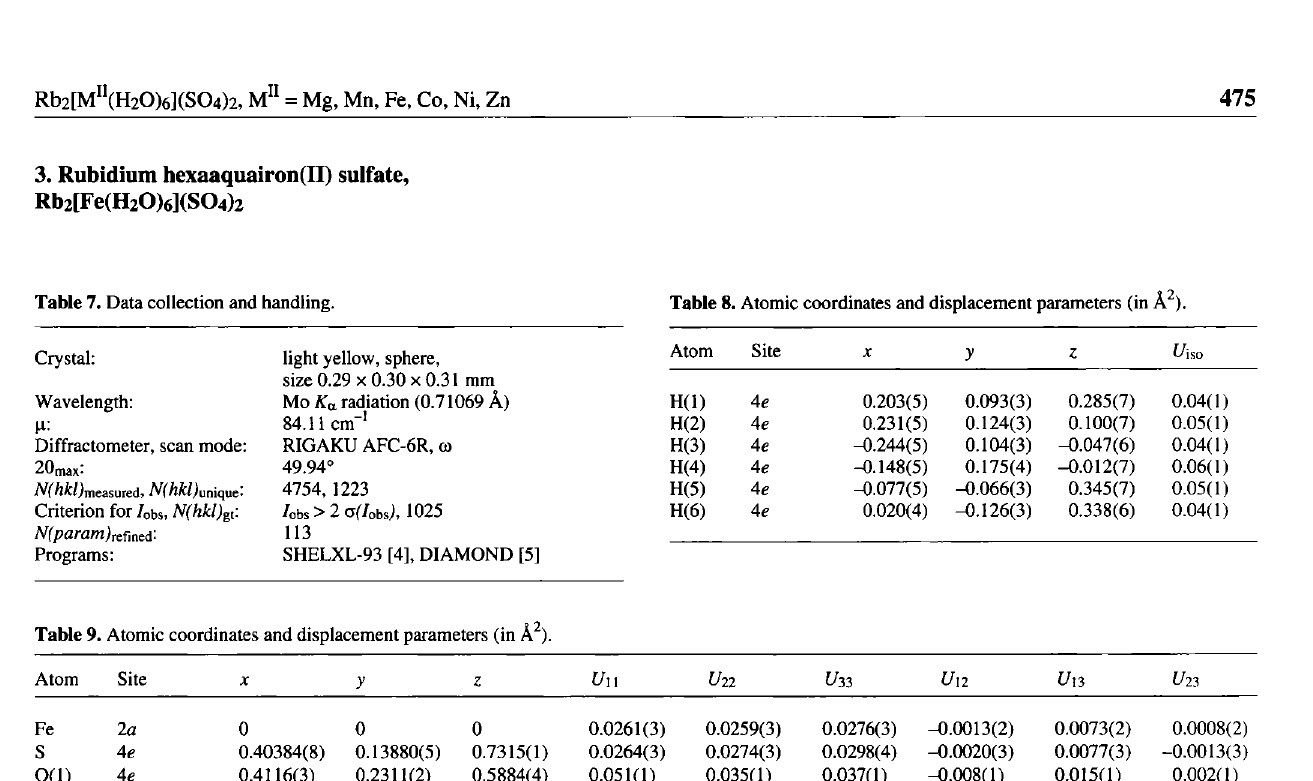
Table 9. Atomic coordinates and displacement parameters (in A 2 ).